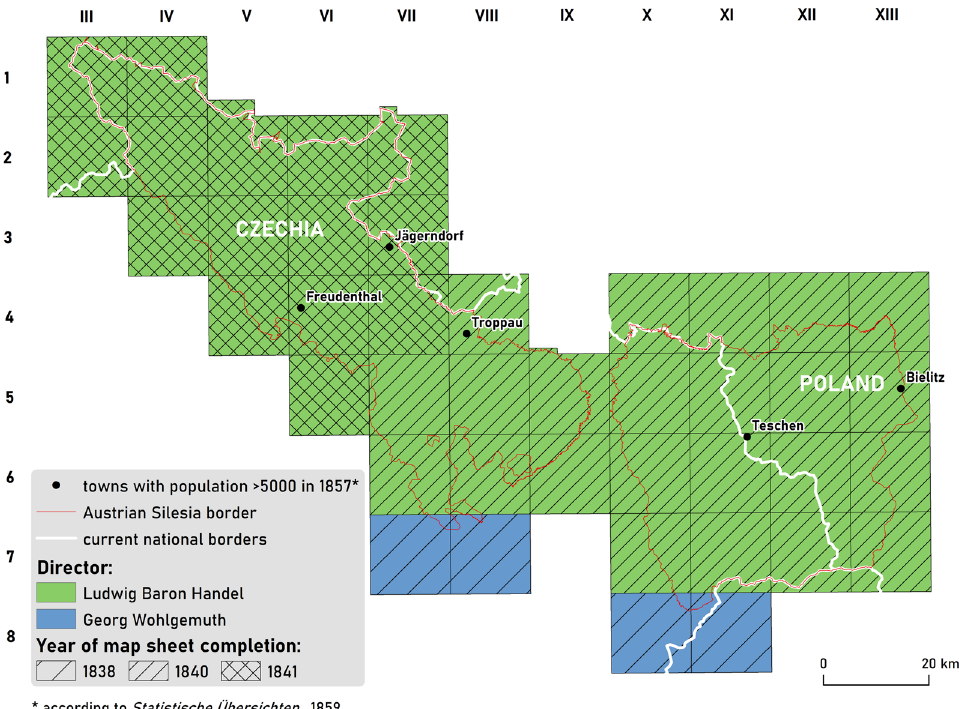
Fig. 3. Map index of the Second Military Survey of Austrian Silesia, including the directors and years in which the sheets were completed. Place names are in the original